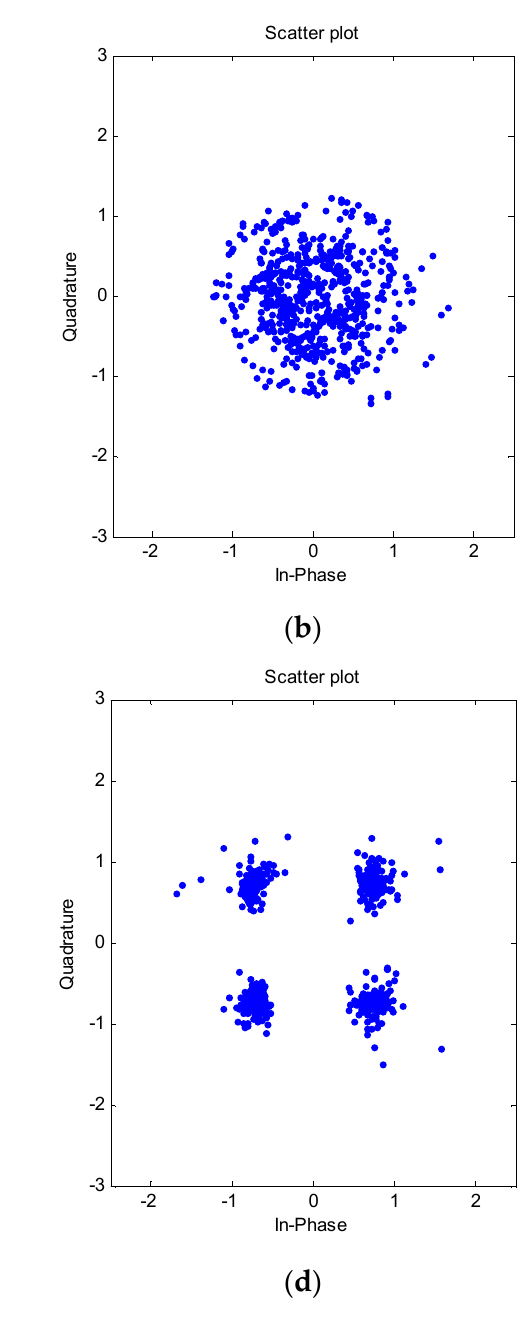
Figure 6. QPSK demapper condition before and after channel compensation: ( a ) transmitted data; ( b ) without channel compensation; ( c ) LS channel estimation; ( d ) DFT channel estimation. Table 4. Dispersion Parameters of NYUSIM